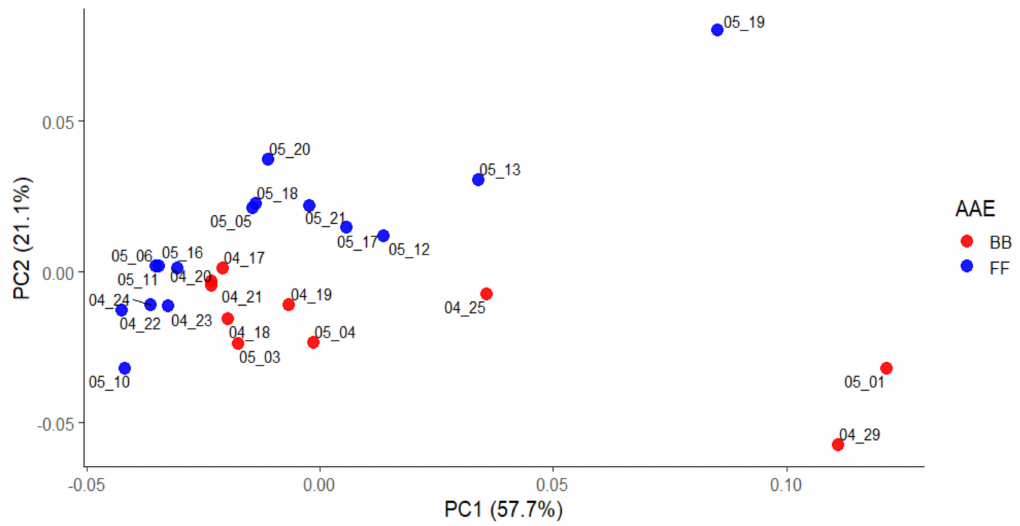
Figure 7. PCA score plots (PC1 × PC2) for FTIR spectra of sampling days marked by red and blue for AAE in the range of 1.61 ± 0.02 and 1.08 ± 0.02, relating to the BB-a ff ected and FF periods,